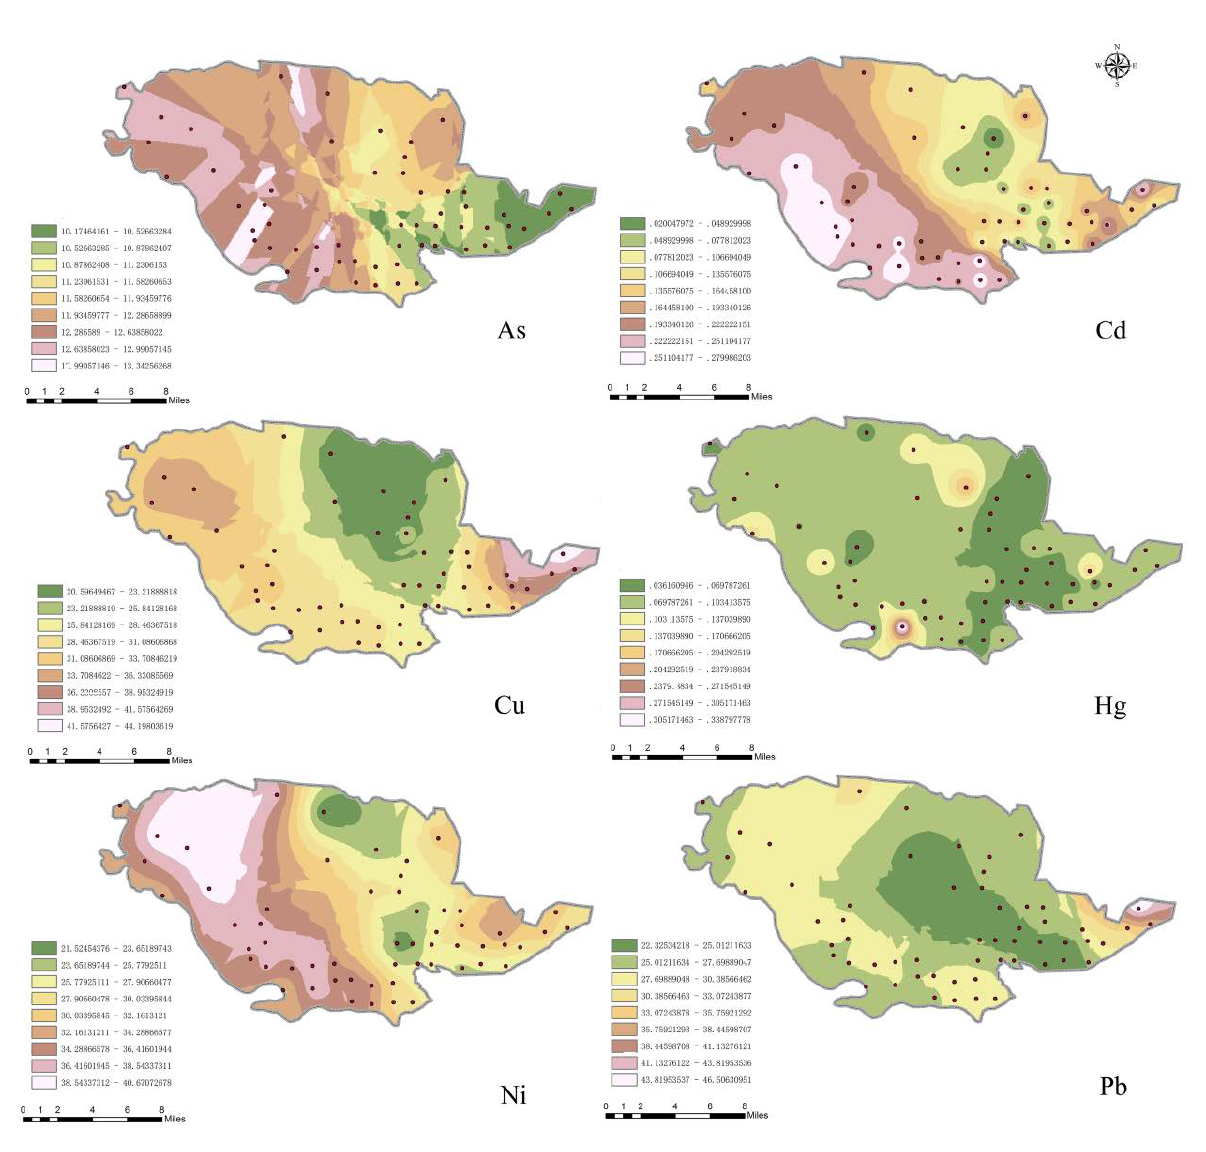
Figure 6: Spatial distribution of heavy metal concentration in the Dongxihu District